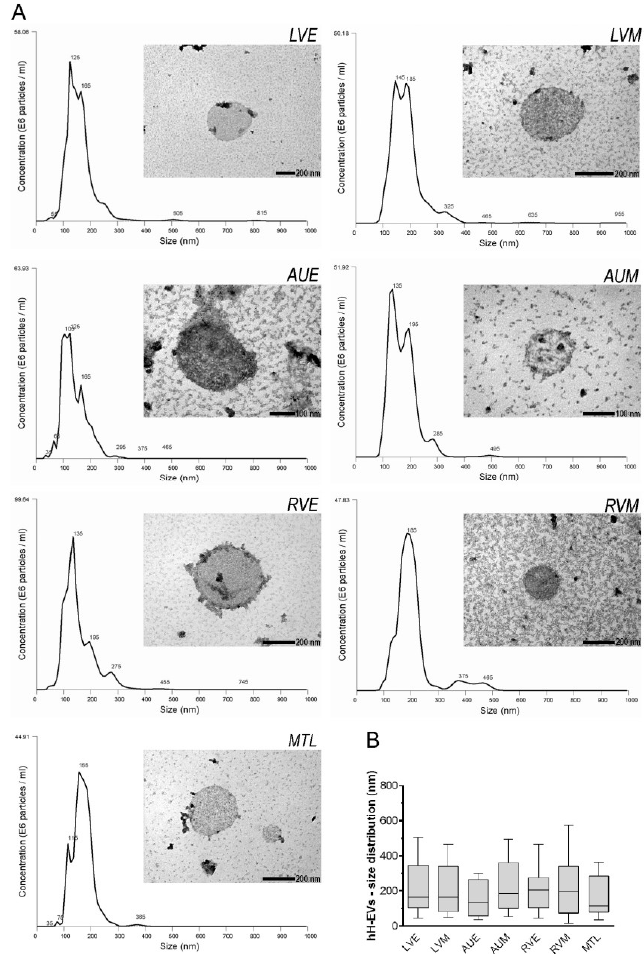
Figure 1. Characterization of hH-EVs. ( A ) Representative graphics from nanoparticle tracking analysis (NTA) and transmission electron microscopy (TEM) images of extracellular vesicles derived from cardiac regions: left ventricular endocardium (LVE), left ventricular myocardium (LVM), right auricle endocardium (AUE), right auricle myocardium (AUM), right ventricular endocardium (RVE), right ventricular myocardium (RVM) and mitral valve leaflet (MTL). ( B ) Analysis of the size and distribution of samples individually examined using NTA.